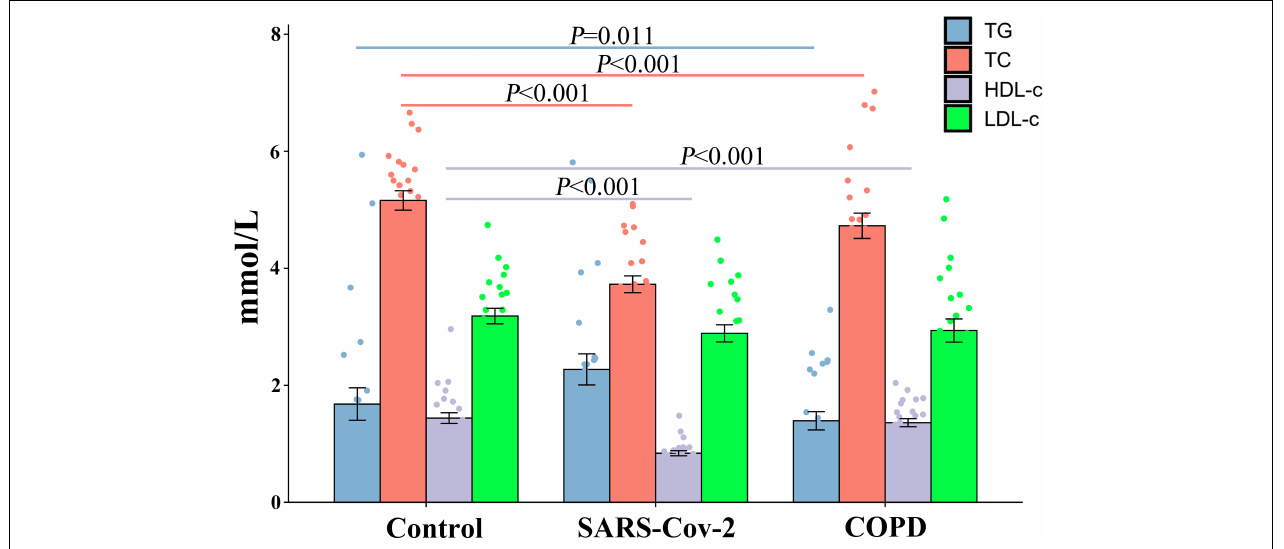
FIGURE 1 | Comparison of the lipid level between the COVID-19, COPD patients, and healthy population. In COVID-19 and COPD patients, TG and HDL-C expression was reduced, but not for TC and LDL-C.